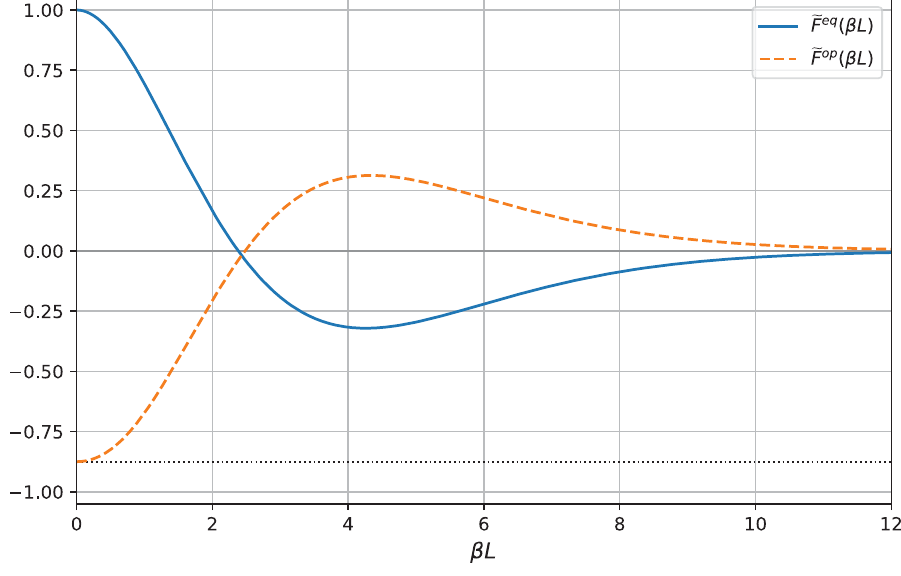
(cid:2) F = F β ( L ) / F qed ( L ), (cid:2) F op ). The